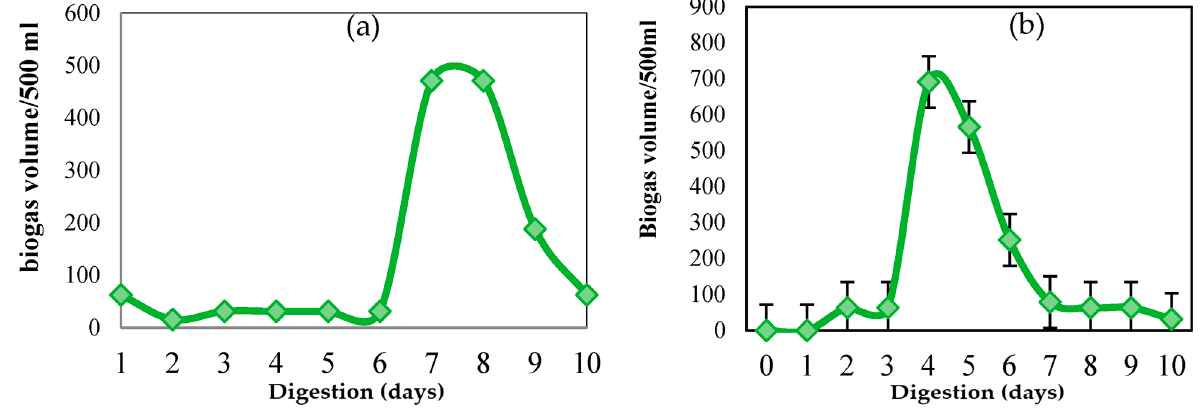
Figure 15. Daily biogas production for digester with HRT = 15 ( a ) and HRT = 20 ( b ) at T= 37 °C, pH = 7 with digestion of 10 days and digester volume of 500 mL.